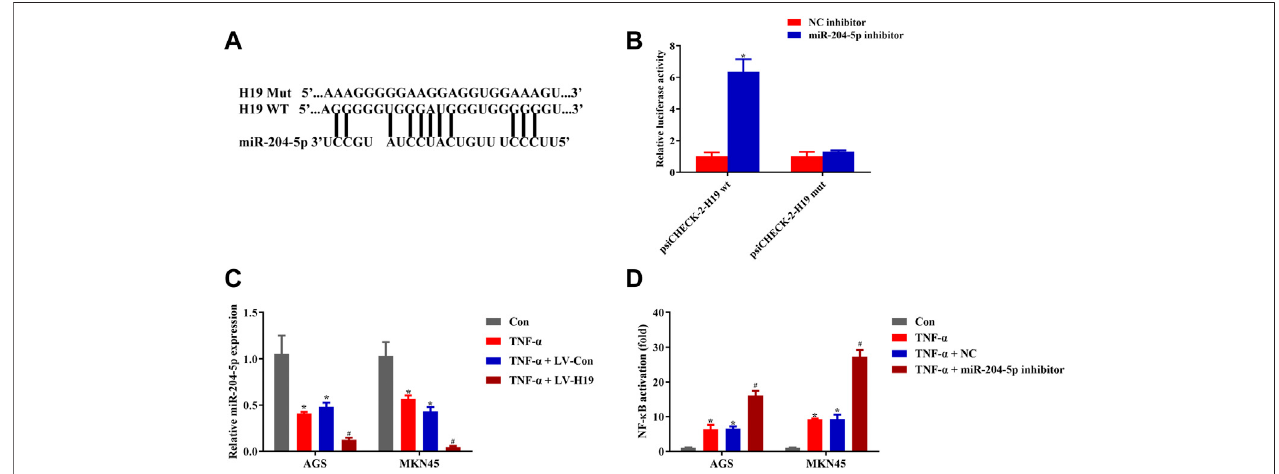
FIGURE 5 | H19 showed direct binding to miR-204-5p. (A) Predicted binding sites between miR-204-5p and H19. (B) Dual-luciferase reporter assay of psiCHECK-2-H19 wt and psiCHECK-2-H19 mut HEK 293T cell cotransfected with miR-204-5p inhibitor or its negative control. (C) Relative mRNA expression of miR- 204-5p in cells transfected with H19 or its negative control and treated with TNF- α (5 ng/ml) for 24 h. (D) Relative NF- κ B activity of cells transfected with miR-204-5p inhibitororitsnegativecontrolandtreatedwithTNF- α (5ng/ml)for24h.Resultswereexpressedasmean±SEM,andstatisticalanalysiswasperformedusingtwo- way ANOVA followed by Tukey ’ s multiple comparison test. * ,# p < 0.05 ( n ≥ 3). * p compared with the control group and # p compared with TNF- α /LV-Con or TNF- α /NC- treated